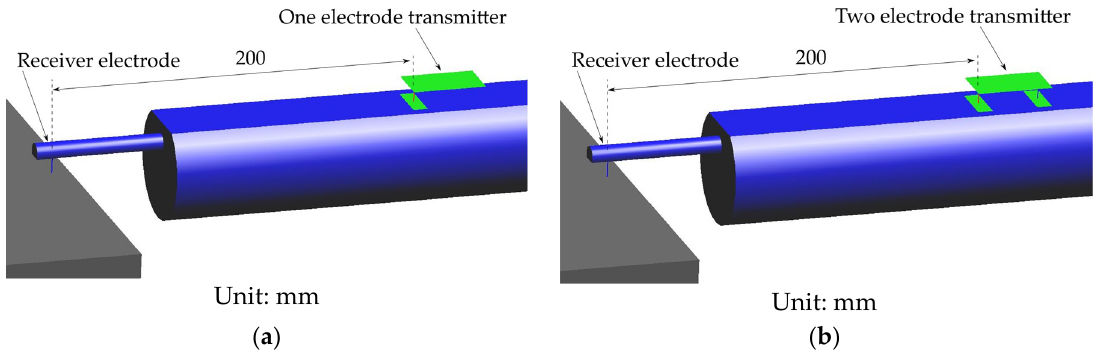
Figure 2. Location of the transmitter and the receiver electrode around the arm: ( a ) One-electrode transmitter; ( b ) Two-electrode transmitter.